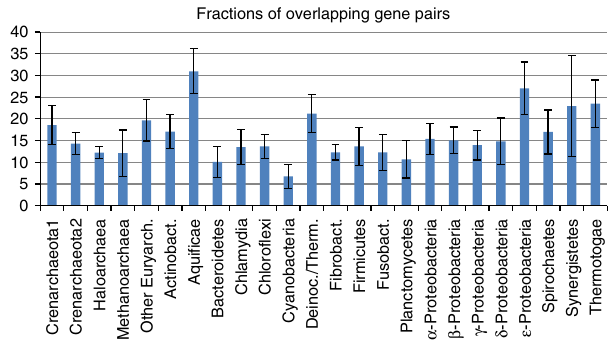
Fig. 2 Overlapping gene pairs in 720 genomes of 24 groups of prokaryotes. Fractions of overlapping gene pairs (%). Mean values and standard deviations are shown